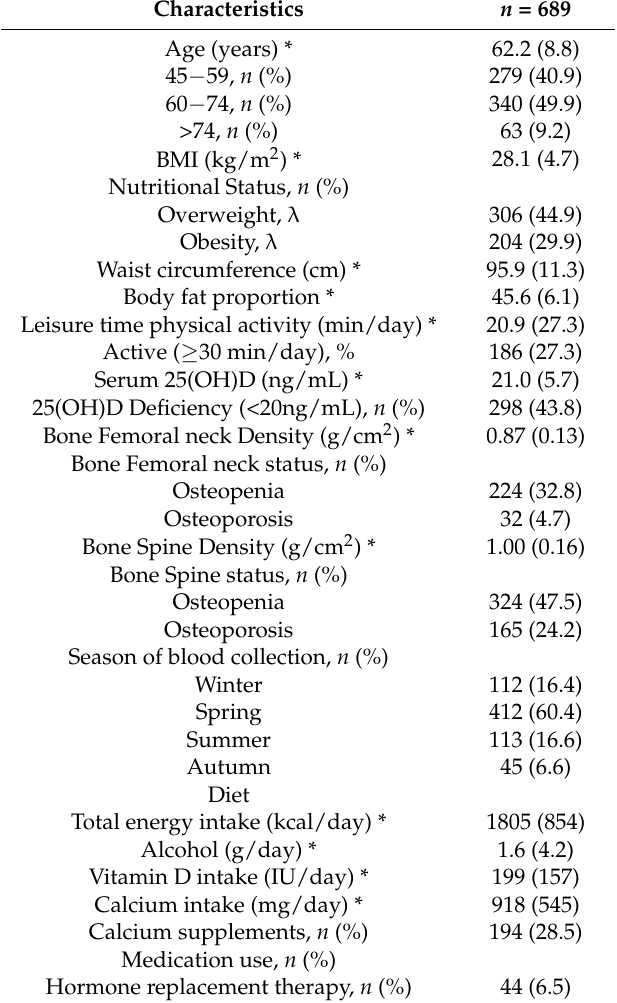
Table 1. Characteristics of postmenopausal women of the Health Workers Cohort Study